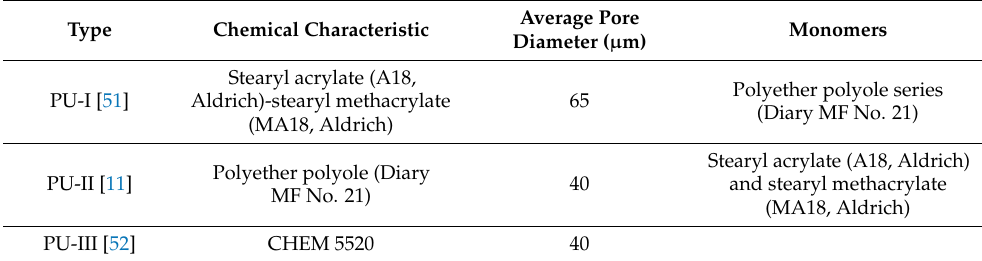
Table 1. Different types of Polyurethane (PU) foams studied in this work.